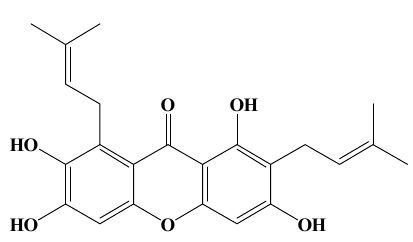
Figure 1. Structure of γ -mangostin.